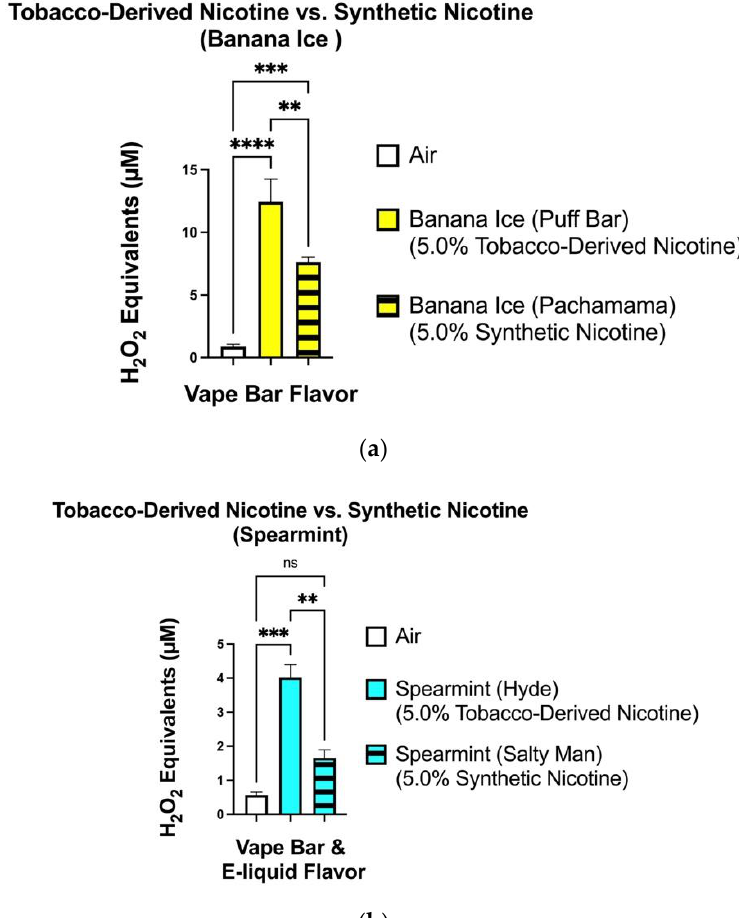
Figure 3. ROS generation among aerosols generated from banana ice ( a ) and spearmint ( b ) flavored TFN and tobacco-derived nicotine-containing vape-products. ROS levels within the generated aerosols from each individual minty/iced (cooled) flavored TFN and tobacco-derived nicotine-containing vape-product was measured via spectrofluorometry and quantified as H 2 O 2 equivalents. During analysis, the level of ROS generated from each individual vape-bar was compared to the ROS generated from the filtered air control. Data are represented as mean ± SEM, and significance was determined by one-way ANOVA. ** p < 0.01, *** p < 0.001, and **** p < 0.0001 versus air controls. ns is abbreviated for “Non-Significant” versus air-controls ( p > 0.05). Sample size (N) = 3 – 4.